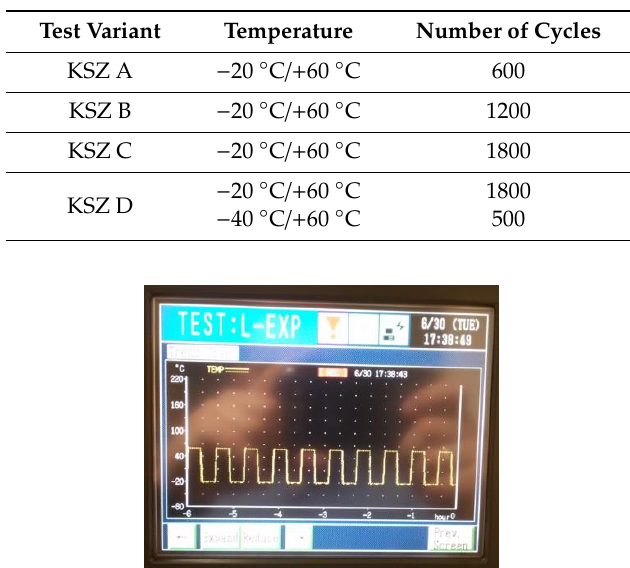
Figure 4. Photograph of the thermal shock chamber screen showing a test cycle.